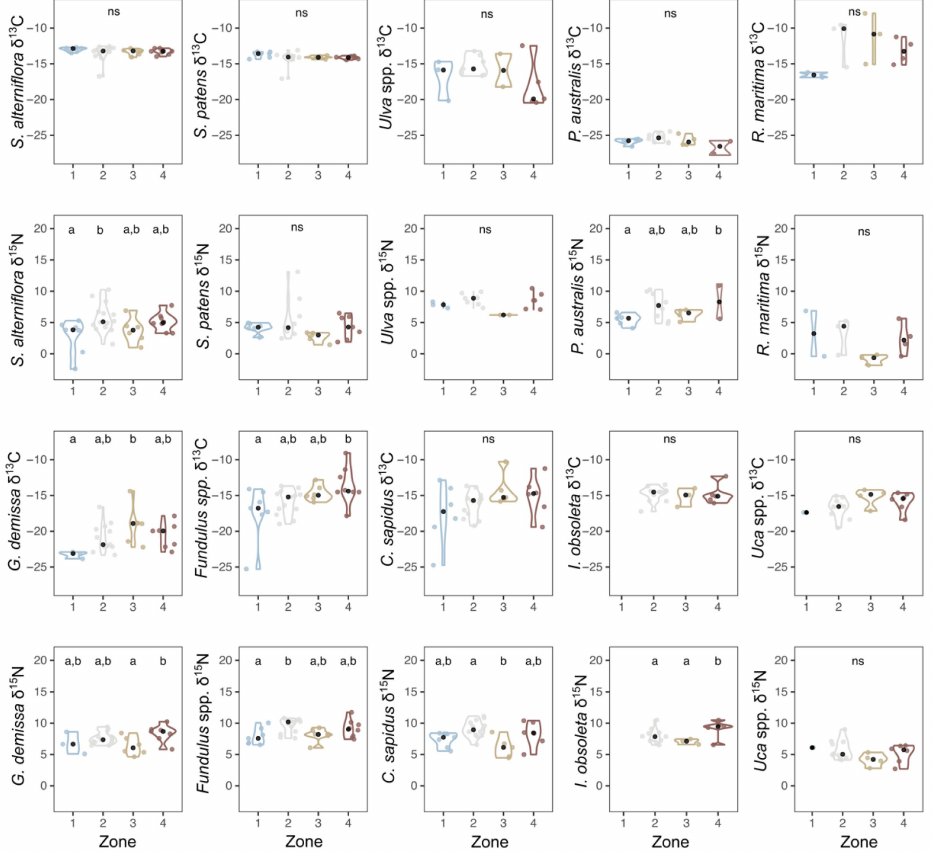
Figure 5. Distribution of δ 13 C and δ 15 N values (in ‰) for biota across the four geographic zones that comprise the BB-LEH-GB. Letters within panels indicate differences among groups, no significant difference is indicated by ‘ns’. For p -values and effect sizes see supplementary Table